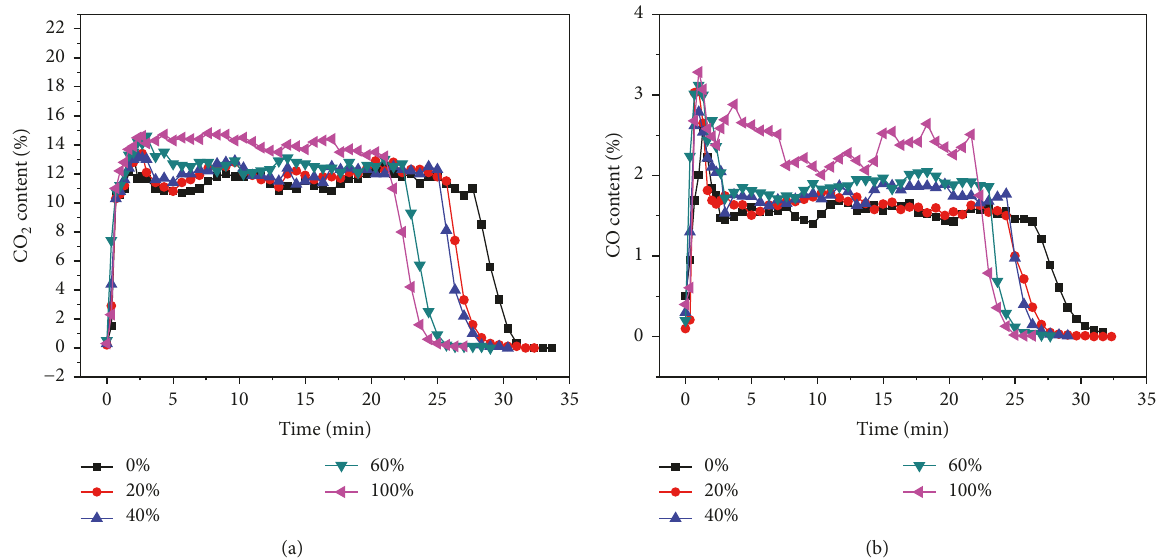
Figure 6: Effect of proportion of biochar replacing coke on COx concentrate of flue gas.